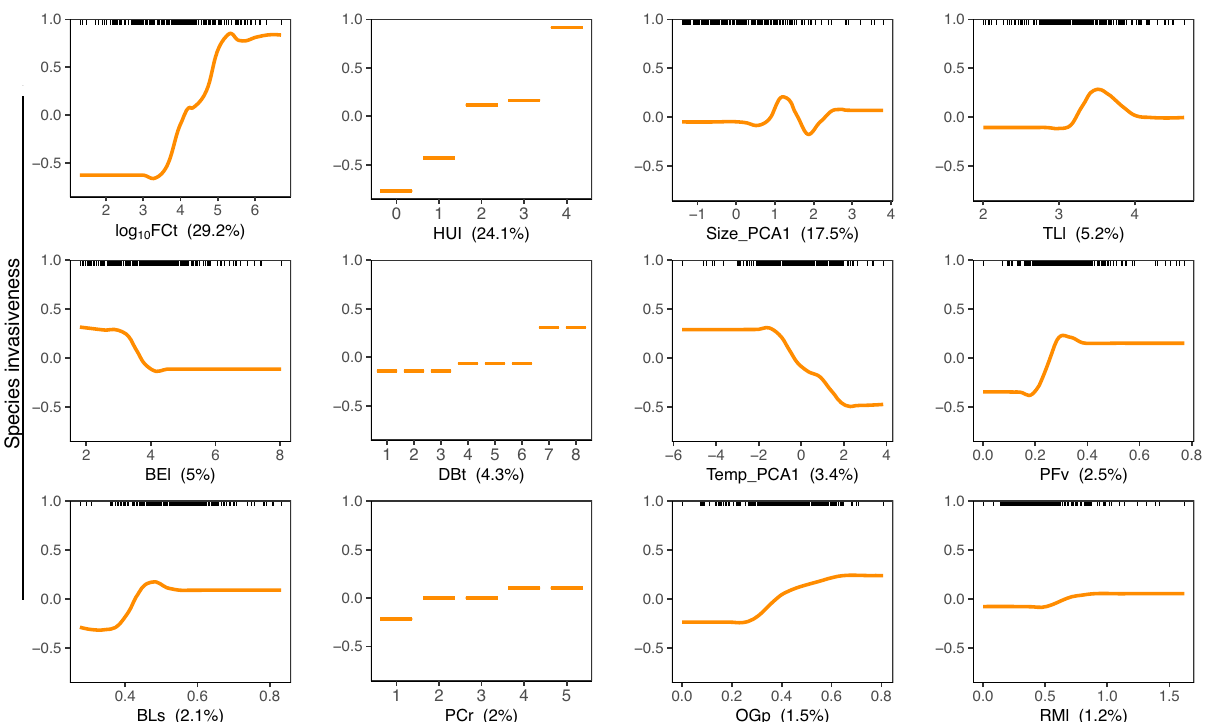
Fig. 2 | Results of boosted regression trees showing the partial dependency between fi sh species invasiveness and the 12 most in fl uencing predictors. The value in parentheses in each panel shows the percentage of contribution of each trait considered in the model. The rugs at the top of each panel show the dis- tribution of the species along the traitvalues. FCt fecundity, HUI human use index, Size_PCA1 fi rst PCA axis of maximum body length, longevity, and mature age, BEl